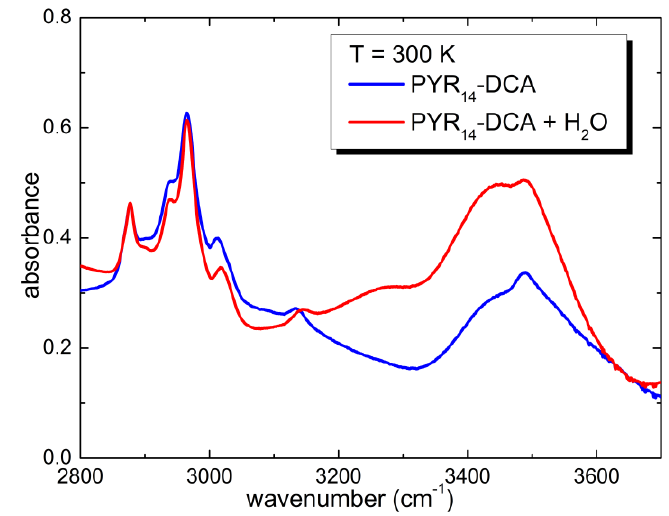
Figure 3. Comparison of the infrared absorption spectra measured at 300K of PYR 14 -DCA and PYR 14 -DCA+H 2 O.